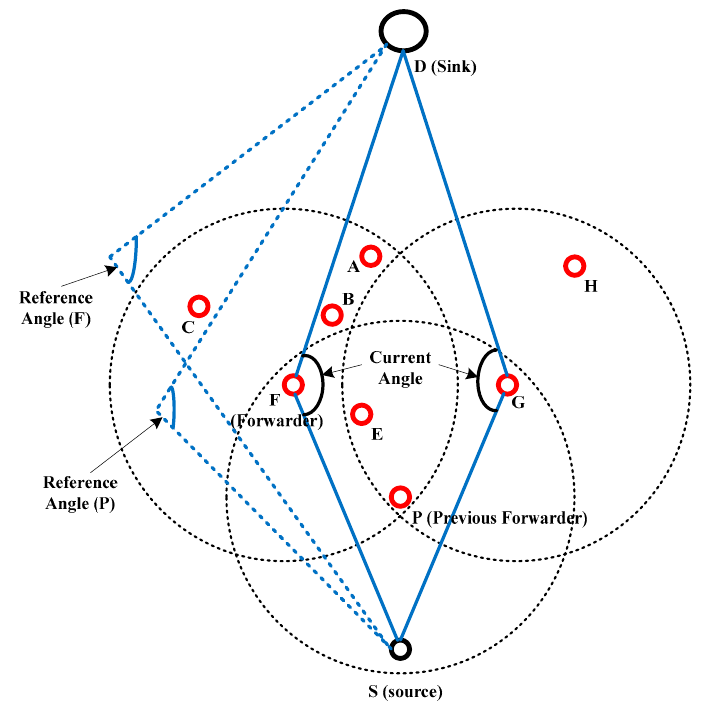
Figure 6. Packet forwarding in DFR.